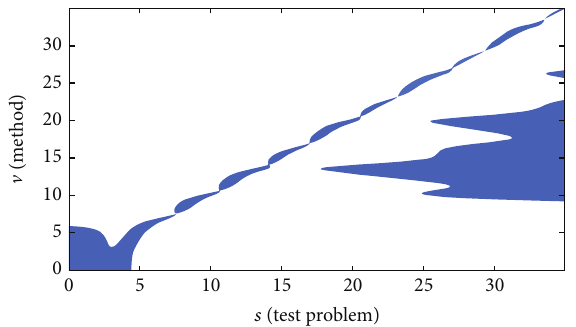
Figure 2: 𝑠 - V plane of the new obtained five-stage symmetric two- stepfourteenth-algebraicordermethodwithvanishedphase-lagand its first, second, and third